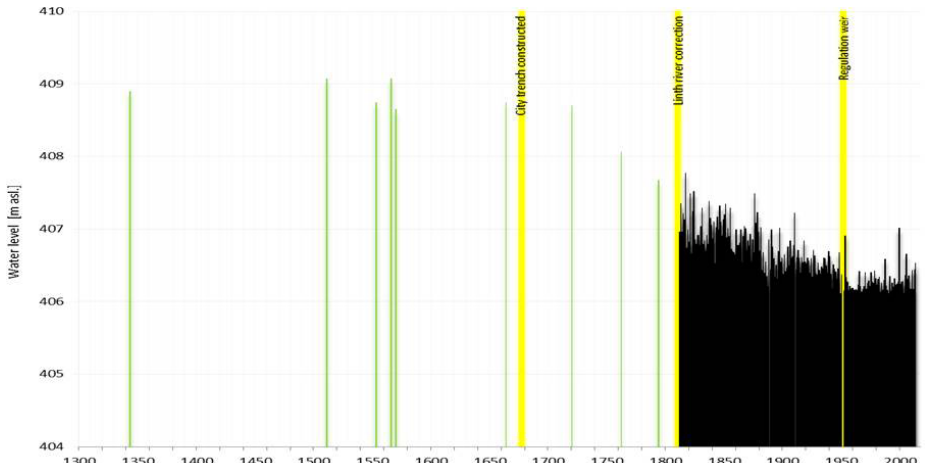
Figure 10. Three-step decrease in flood magnitudes for Lake Zürich and the River Limmat in Zürich (Näf et al., 2016; Wetter and Specker,